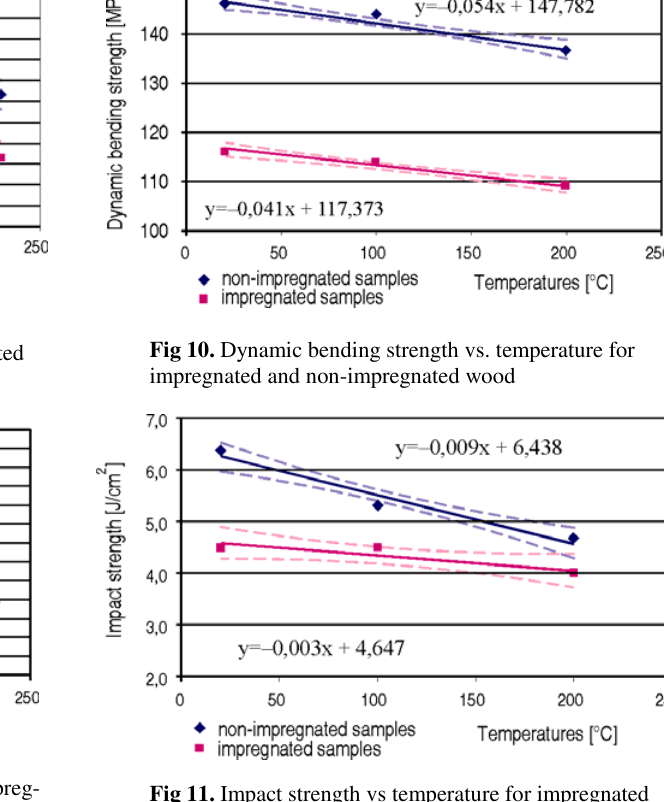
Fig 11. Impact strength vs temperature for